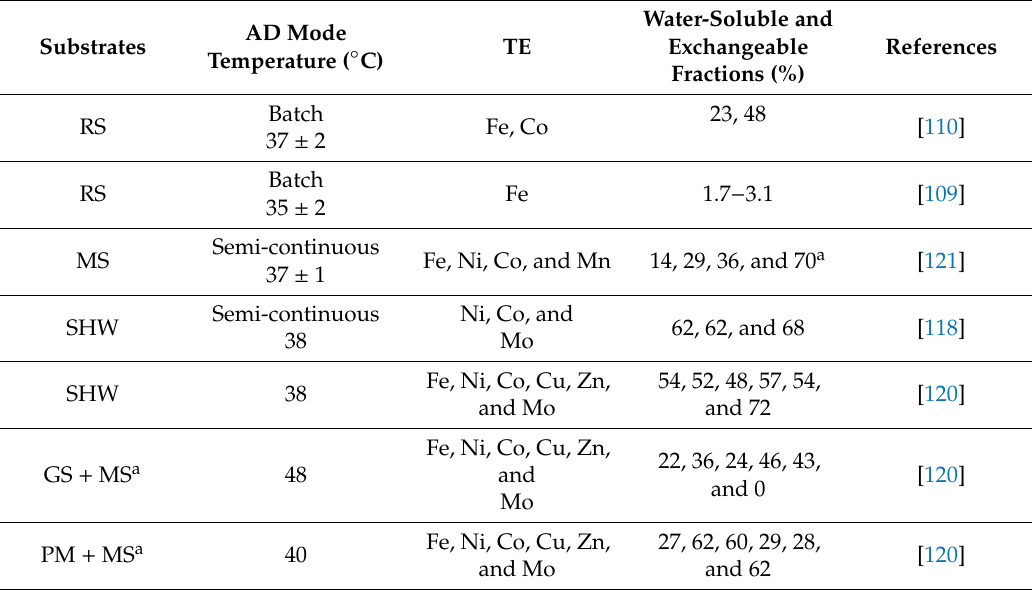
Table 10. Water-soluble and exchangeable fractions (relative to a total concentration of TE) of TEs in the AD of various